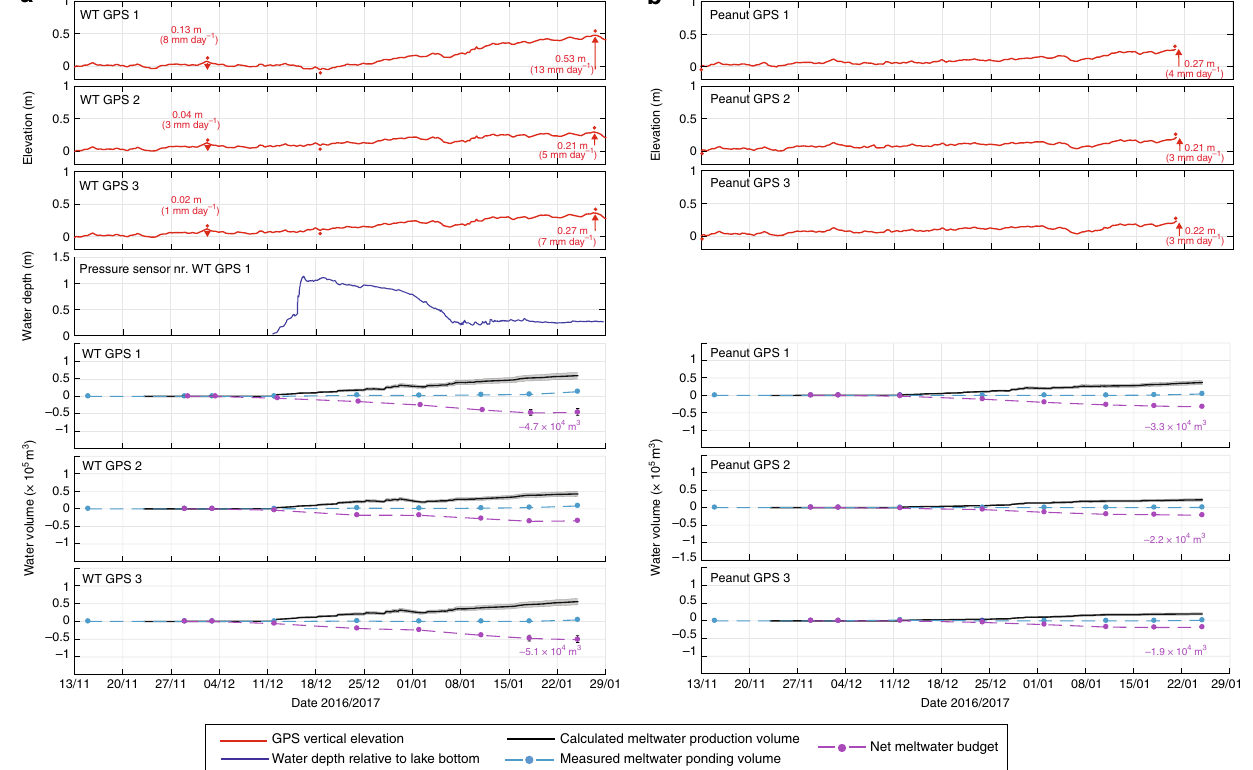
Fig. 4 Vertical ice shelf displacement with water depths and seasonal meltwater budgets for WT and Peanut lake sites. a is for WT and b is for Peanut. For each site, the top three plots show the vertical ice-shelf displacement (relative to arbitrary elevation) from three GPS stations (Fig. 1b, red stars). The fi rst red dot above each time series shows when GPS 1 reaches its highest elevation, before reaching its lowest elevation, shown by a second red dot. The third red dot indicates when GPS 1 reaches its highest elevation during the whole time period. Numbers next to red arrows (which depict the direction of movement) are the total vertical de fl ections, and de fl ection rates, measured by each GPS over the two respective time periods between the fi rst and second red dots, and the second and third red dots. The fourth plot for the WT site shows water depth data from a pressure sensor nearest to GPS 1 (Fig. 1b, green open circles). The bottom three plots for each site show the calculated seasonal net meltwater budgets around each GPS station. The black lines (and grey shaded areas) show cumulative volumes of meltwater production (and errors) calculated by a PDD model; light blue dots show the measured volumes of meltwater ponding from 9 cloud-free Landsat 8 images (see Supplementary Table 2 for image dates), and the dashed-light blue lines show these data linearly interpolated between the image dates; purple dots (and whiskers) show the net meltwater budget (and errors) on each image date, and the dashed-purple lines show these data linearly interpolated between the dates. Purple numbers next to the net meltwater budget plots refer to the seasonal net meltwater budgets, each de fi ned as the maximum minus minimum net meltwater budget during the melt season, which are all negative. See Methods for details of GPS and water-depth data processing, and meltwater budget and error